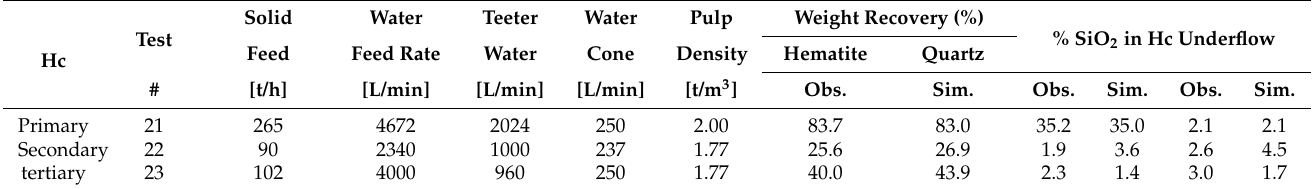
Table 3. Observed and simulated performance indices for the primary, secondary and tertiary Hcs of the ArcelorMittal pellet